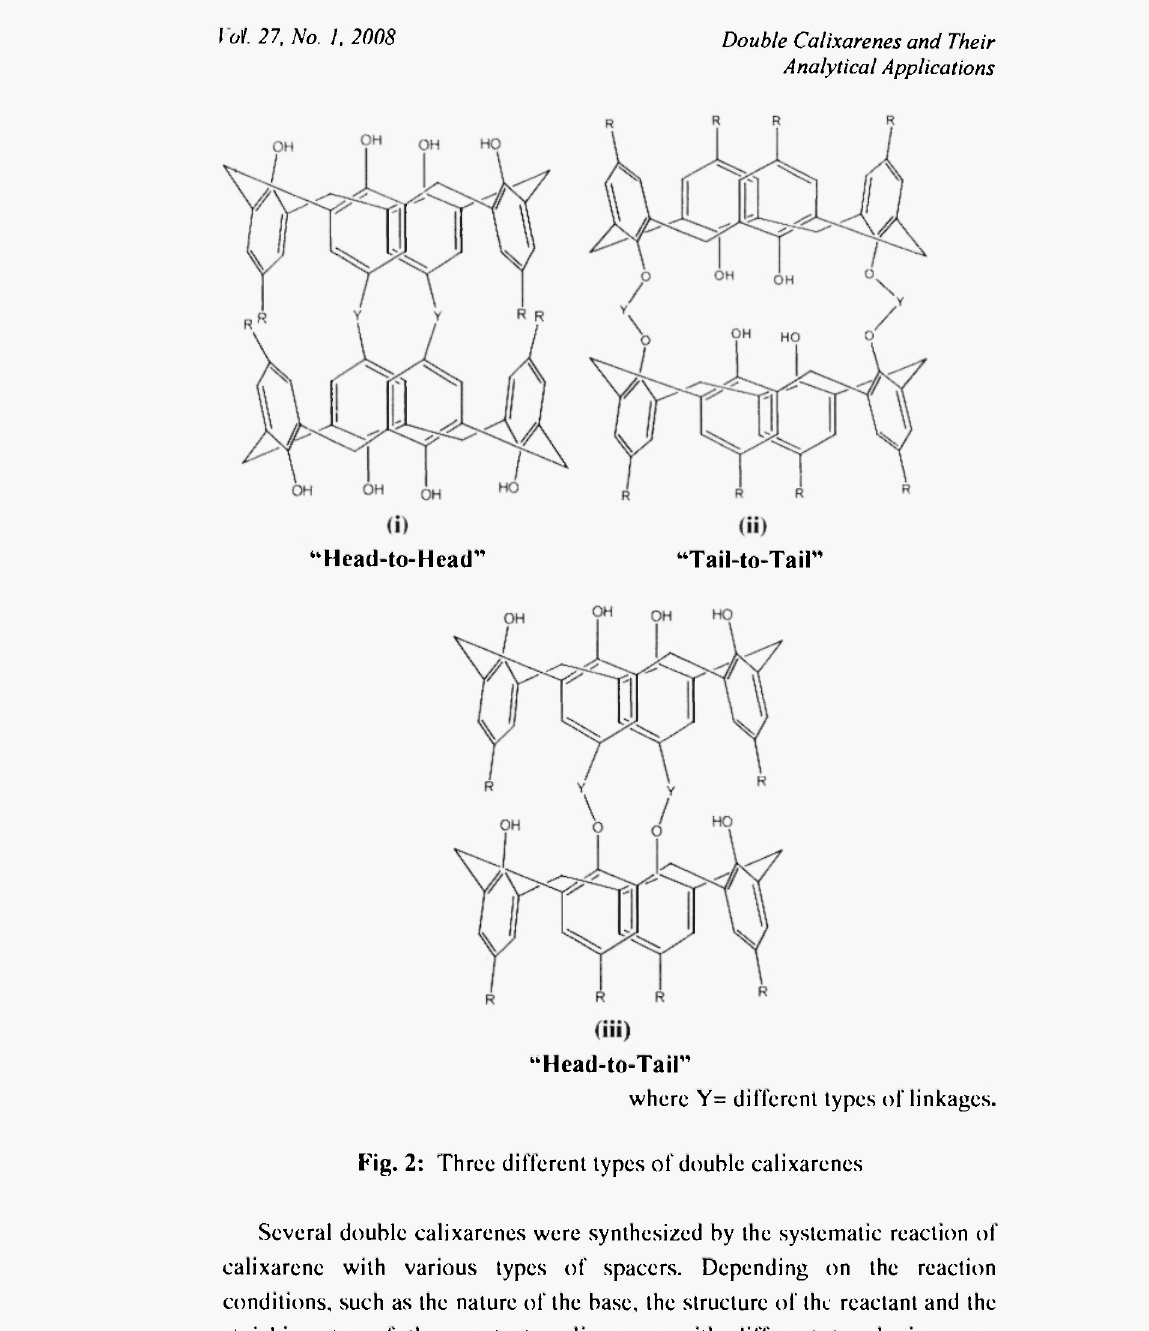
Fig. 2: Three different types of double